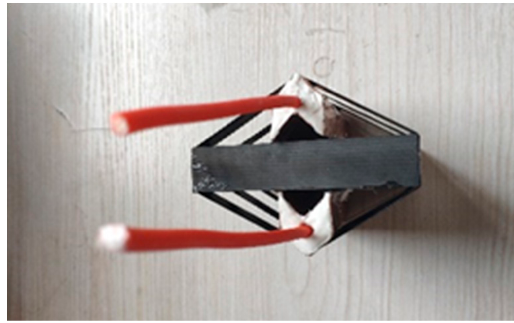
Figure 3. Shaped energy jet cutting charge structure.